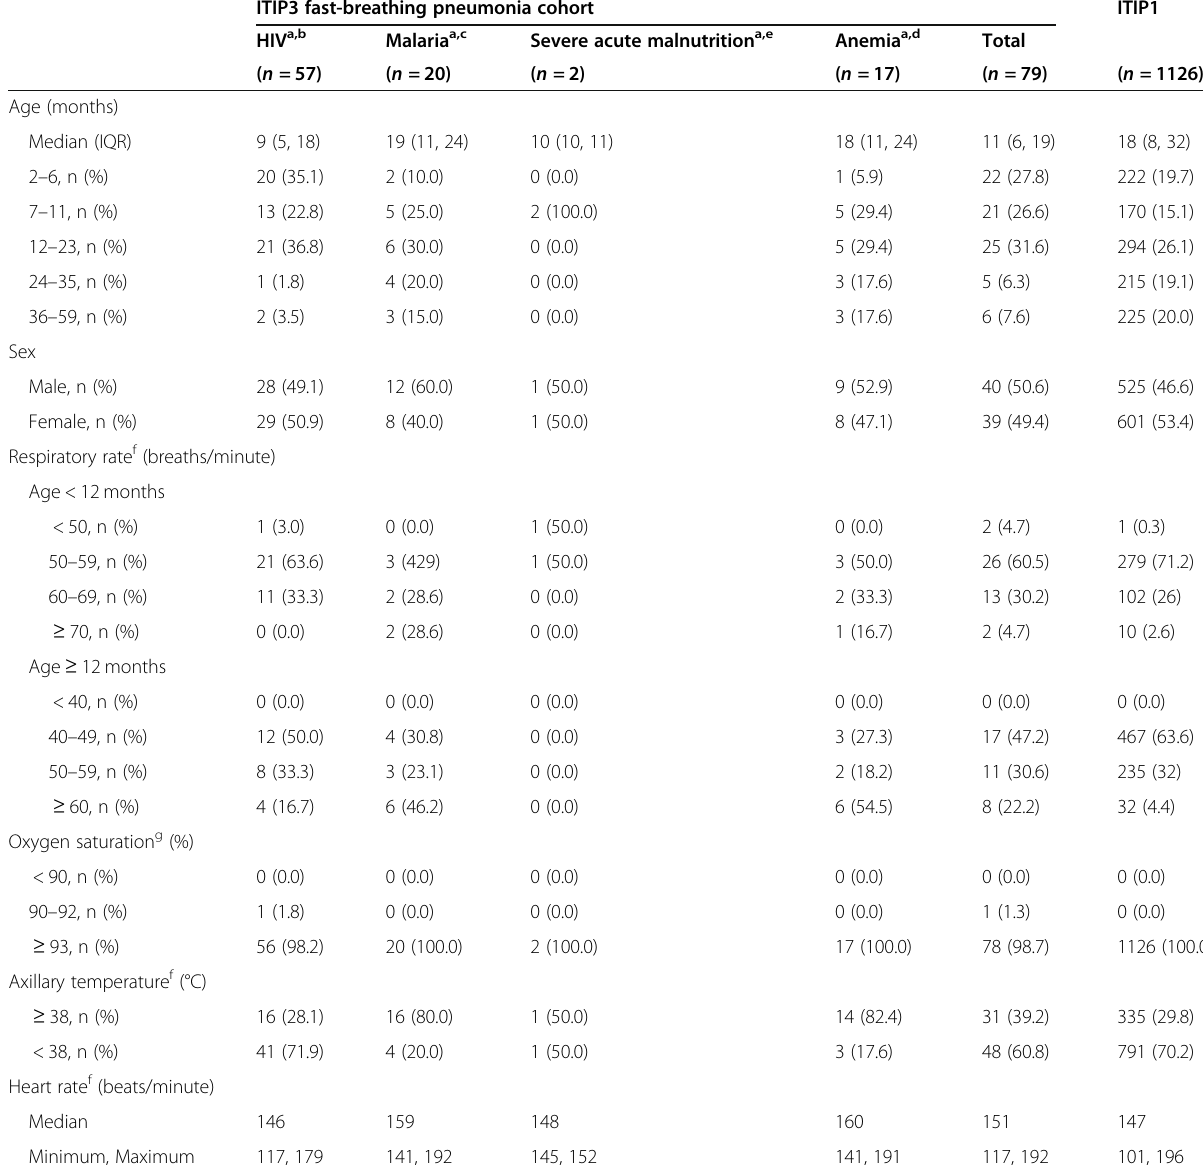
Table 2 ITIP3 fast-breathing pneumonia cohort and ITIP1 baseline characteristics ITIP3 fast-breathing pneumonia cohort